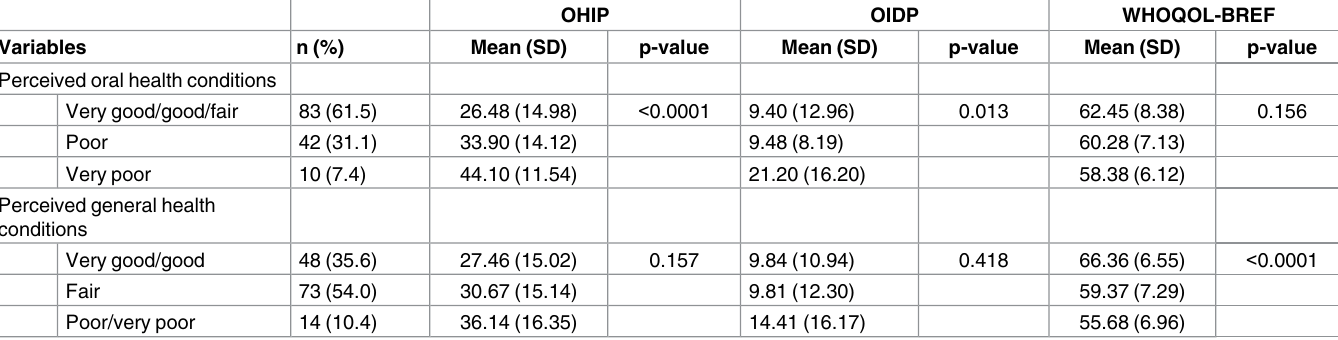
Table 3. Discriminatory ability of all measurements in perceived oral and general health condition.